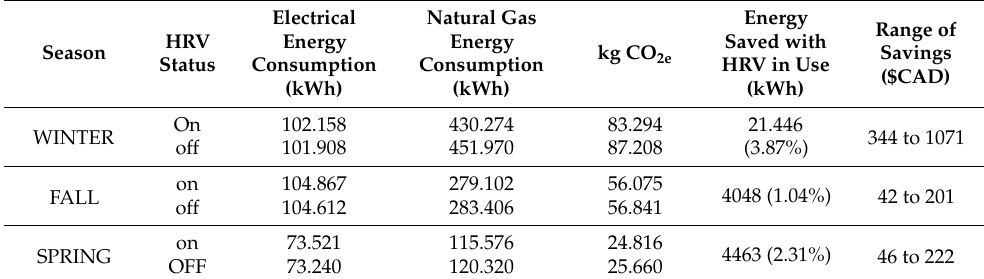
Table 11. Summary of HRV results.